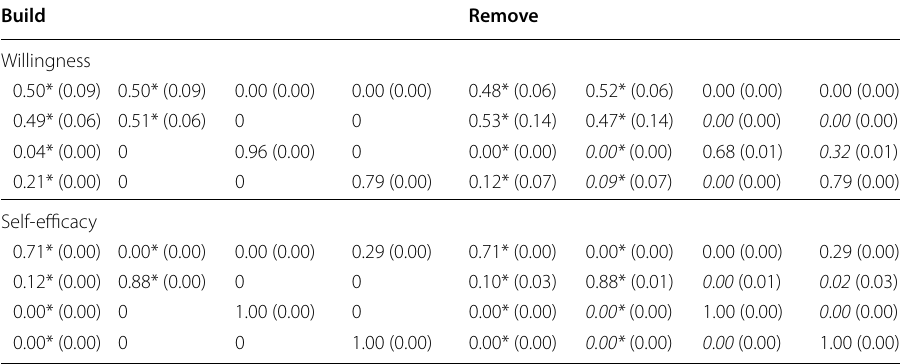
Estimated weights and standard deviations for willingness and self‑efficacy across 10 runs for network 5 using network built with connections known to exist and network where connections known not to exist are removed